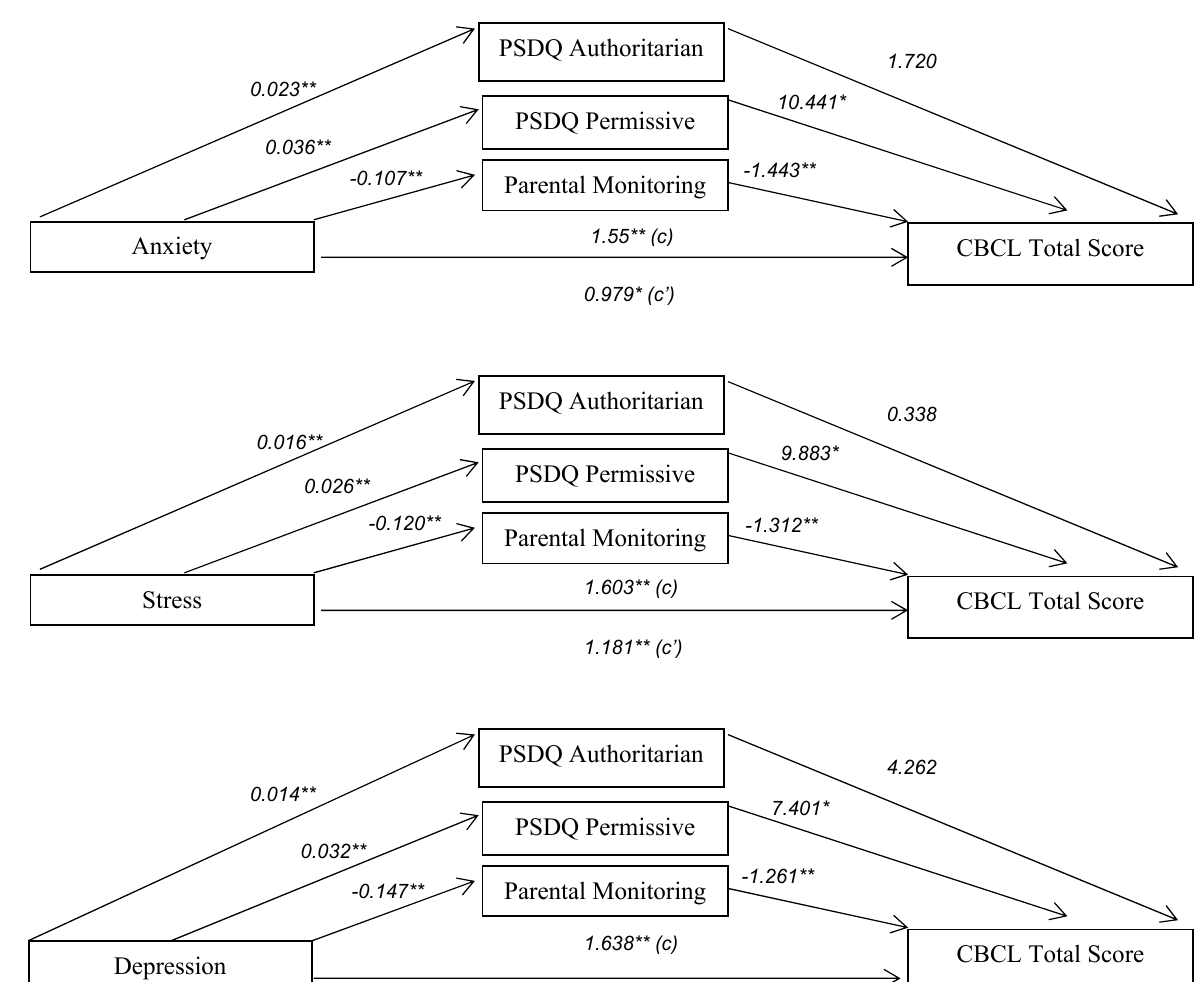
Figure 3. Parenting approaches and monitoring skill as mediators of the relation between parental mental health and child problem behaviours. Note * p <. 05, **p<. 01